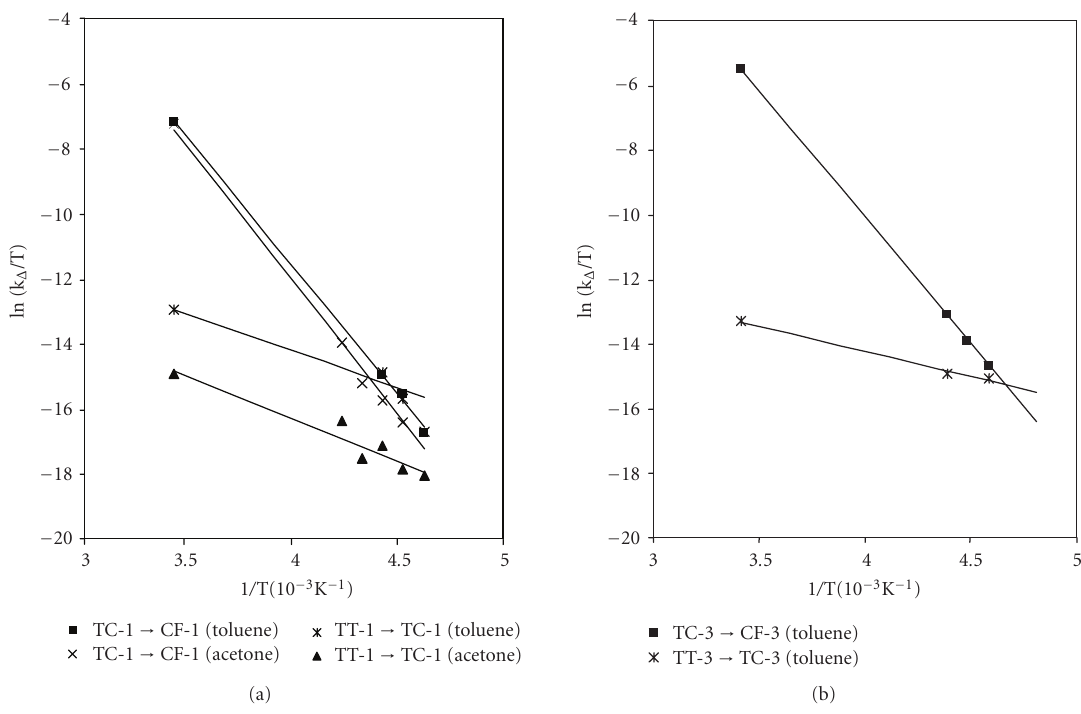
Figure 4: Eyring’s plots of the TT → TC → CF relaxation processes in CF-1 and CF-3.